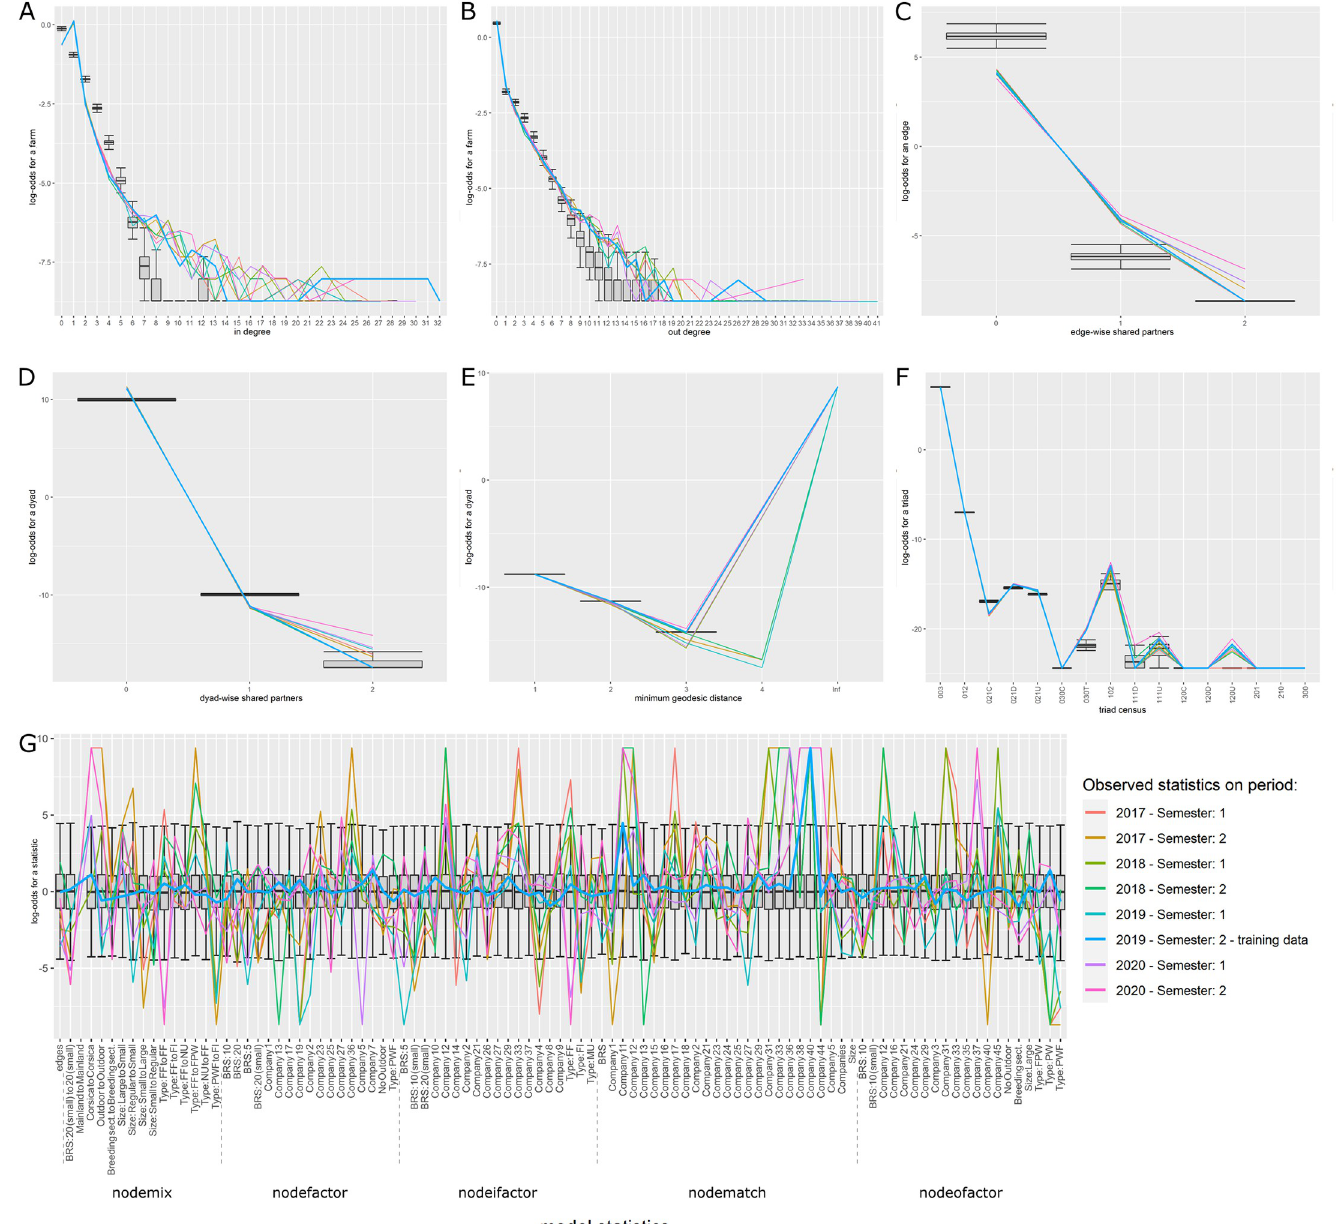
Fig 7. Goodness of fit of the growing pigs model. Goodness of fit of the model adjusted for the transport of growing pigs. Metrics of 6000 simulated networks (boxplot) are compared to metrics of observed semestrial network. Data of the second semester of 2019 were used for model fit (thick blue line). Colors correspond to different semesters’ networks. Details of the network metrics: A: indegree distribution, B: outdegree distribution, C: edgewise shared partners distribution, D: dyadwise shared partners distribution, E: minimum geodesic distance distribution, F: triads census, G: performance of the final model on in-model statistics.